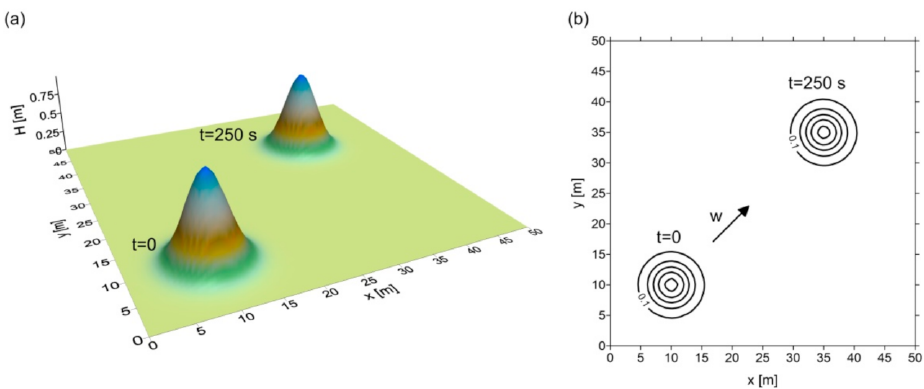
Figure 7. Initial condition ( t = 0) and exact solution ( t = 250 s)—the initial wave is only advected along the diagonal with the constant velocity w : ( a ) water surface elevation; ( b )